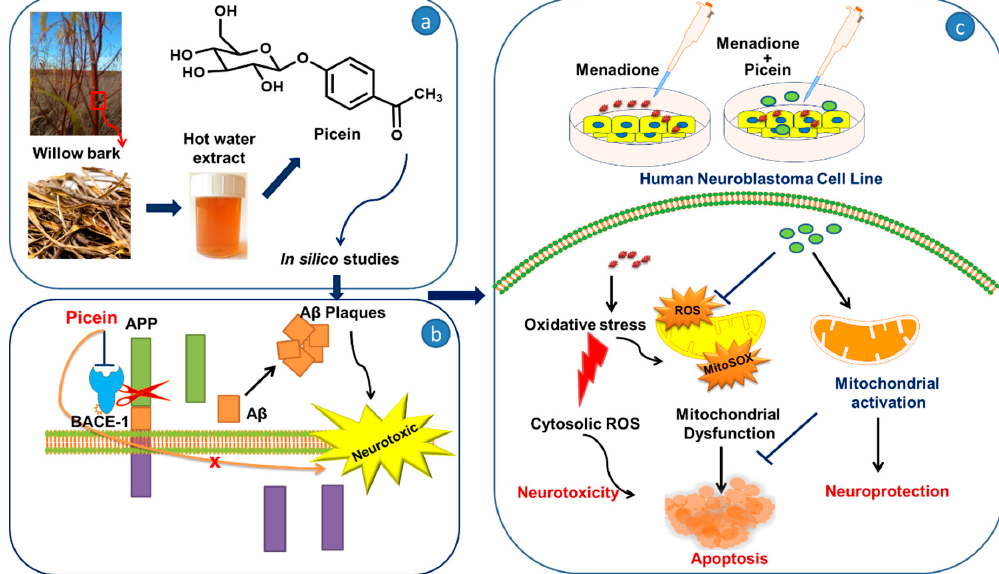
Figure 1. An overview of the experimental plan representing ( a ) the isolation of picein from willow bark [18] followed by its ( b ) in silico and ( c ) in vitro studies. In silico studies for the identification of putative biomolecular target reveals Beta Secretase 1 (BACE-1) as the highest-ranked target enzyme for picein, which might indicate its neuroprotective role. Amyloid precursor protein (APP) is a prerequisite for β -amyloid (A β ) formation, which is sequentially cleaved by BACE1. In vitro studies on SHSY5Y cells shows that menadione induces mitochondrial ROS, superoxide production and also mitochondrial depolarization which lead to mitochondrial damage and ultimately apoptosis of the cell. Furthermore, subsequent treatment with picein recovers the mitochondrial function through its antioxidative e ff ects and thus plays an important role in